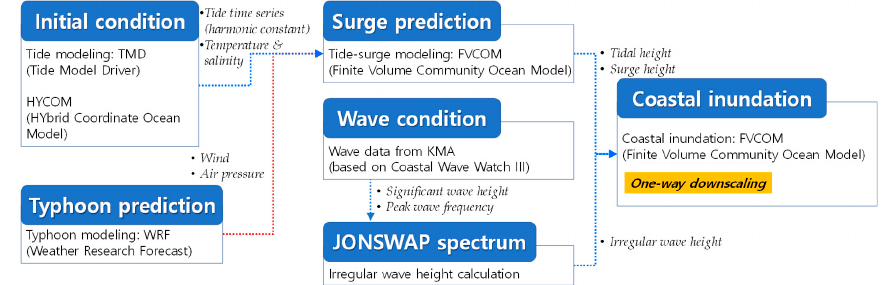
Figure 1. Conceptual diagram of analysis system and data